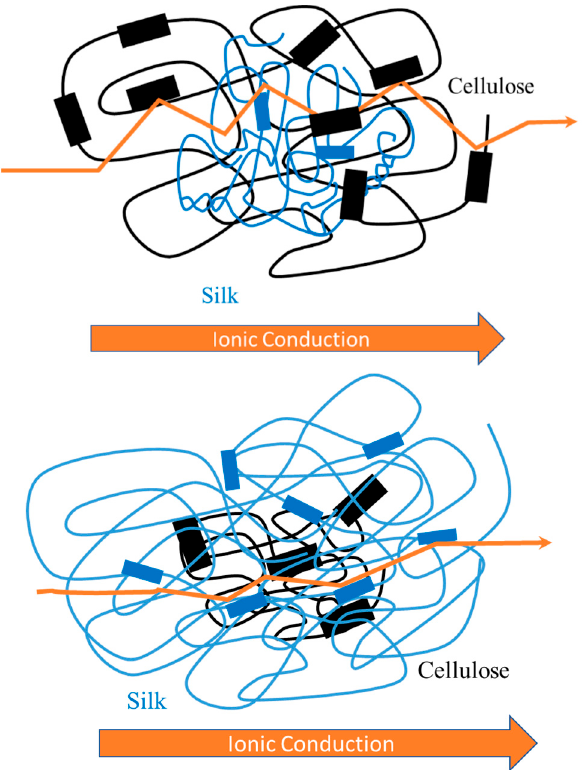
Figure 9. Schematic representation of ion diffusion in a solid electrolyte based on two different compositions of silk/cellulose biocomposites. The top diagram represents 25% silk, and the bottom diagram represents 75% silk.